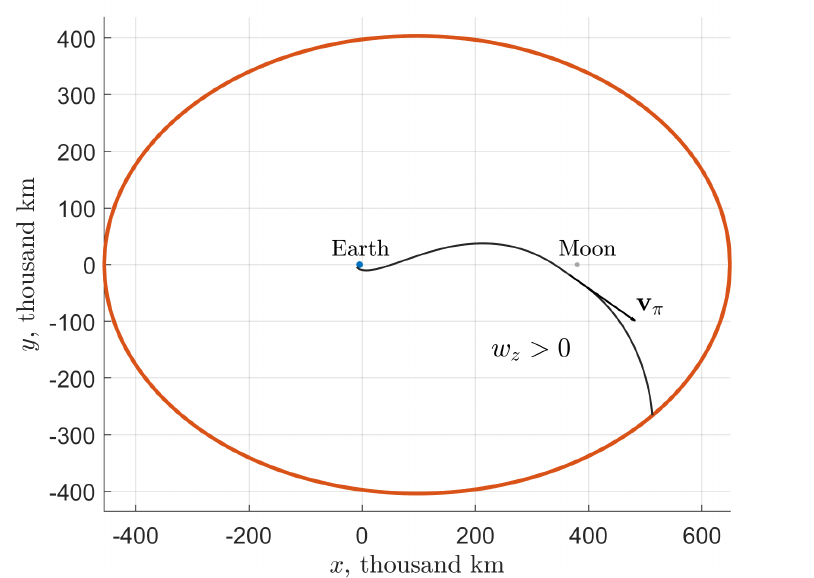
Figure 13. Sample departing leg with a direct lunar flyby. The orbital angular momentum with respect to the Moon in the rotating frame is positive; the spacecraft crosses the x -axis in front of the